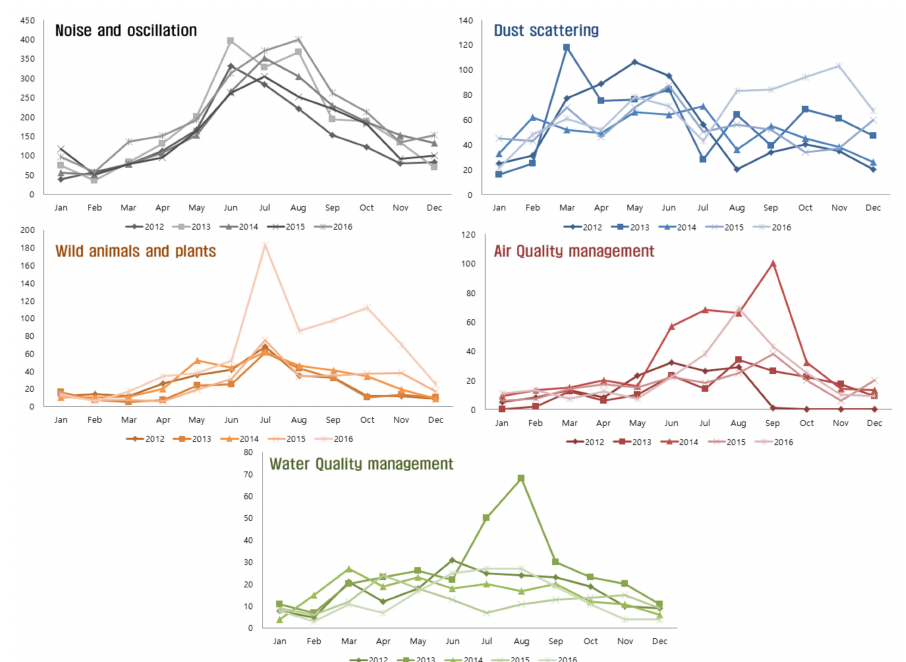
Figure 3. Monthly changes in public complaints per